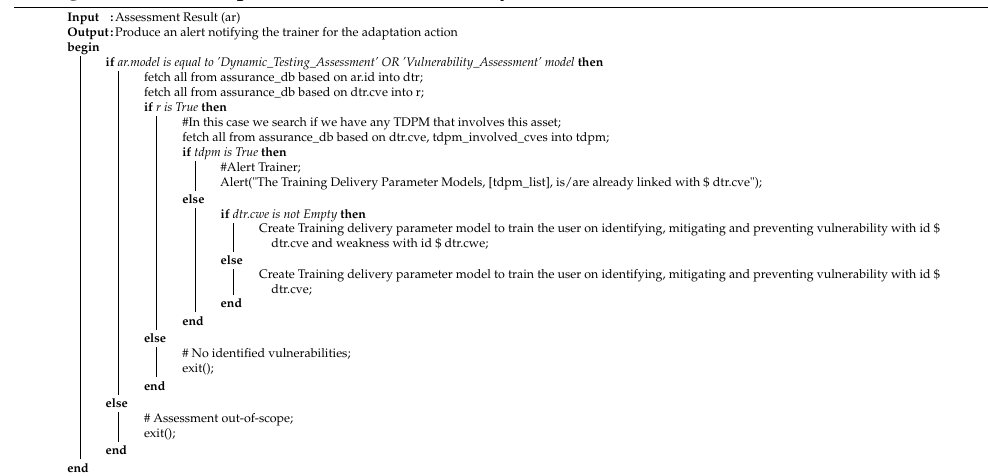
Algorithm 3: Adaptation based on a newly inserted vulnerable asset